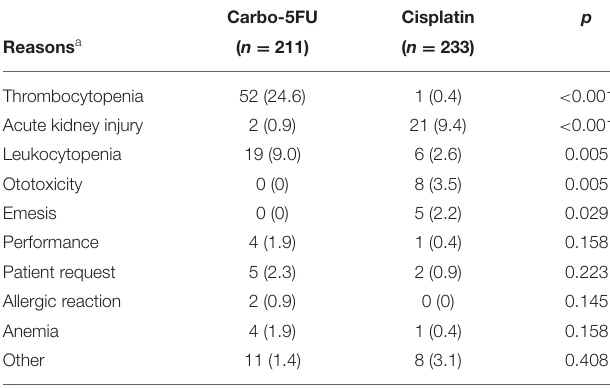
TABLE 3 | Reasons for discontinuation of